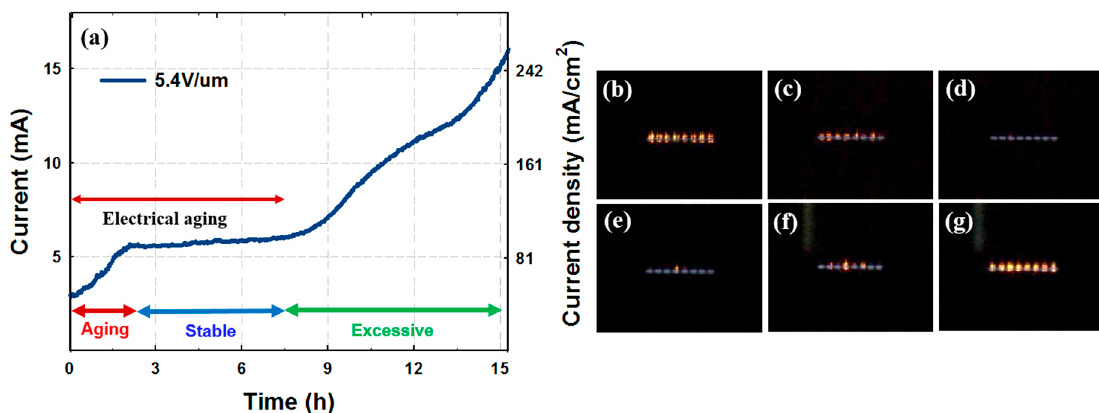
Figure 4. Definition of electrical aging. ( a ) Variation of electron emission current at a higher emission regime with time; ( b ) the section at which Joule heating occurs sufficiently; ( c ) the section at which Joule heating is reduced; ( d ) the section at which Joule heating disappears completely; ( e ) the section at which Joule heating reappears; ( f ) the section at which Joule heating increases; ( g ) excessive Joule heating that can cause damage to the CNT emitters.